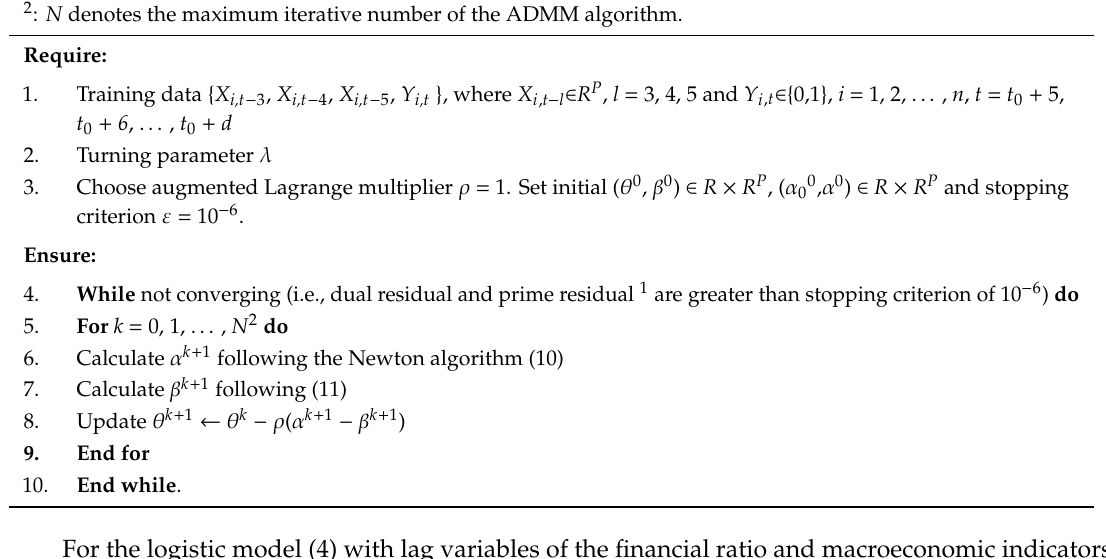
Algorithm 1. An alternating direction method of multipliers (ADMM) algorithm framework for lasso–logistic with lagged variables (5). 1 : Dual residual and prime residua denote || β k + 1 − β k || 2 and || α k + 1 − β k + 1 || 2